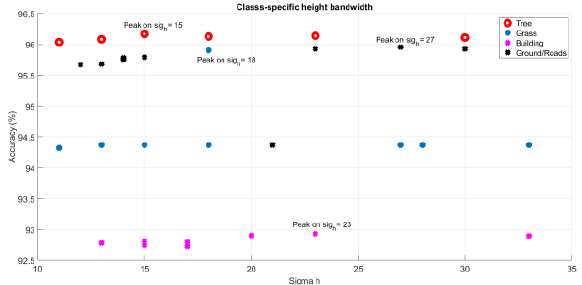
Figure 5. The Accuracy of each class in dataset I according to the height bandwidth.